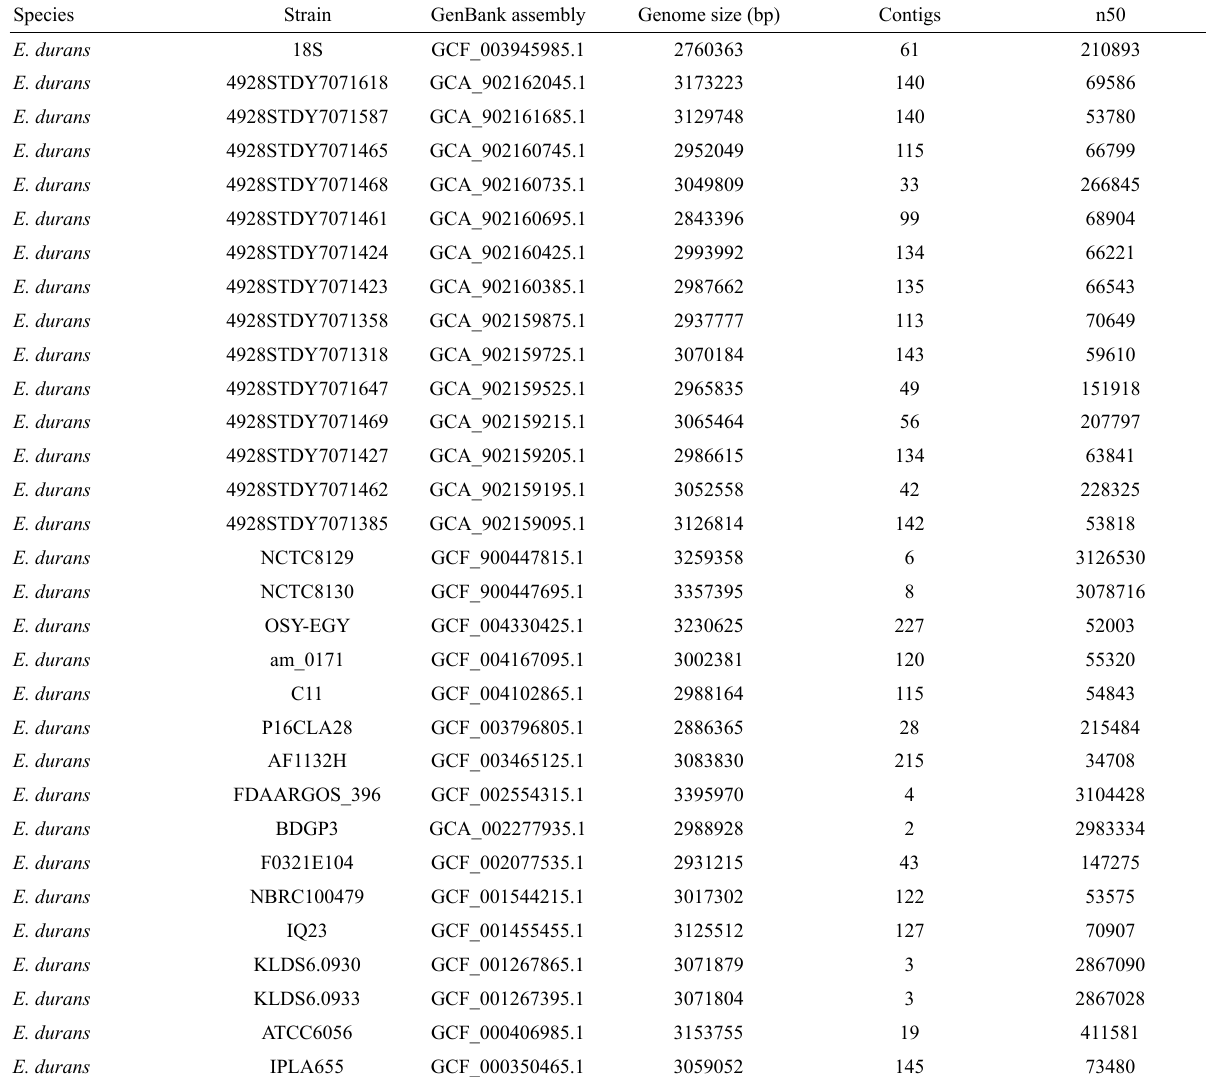
Table 1 – Complementary information of Enterococcus durans genomes from NCBI. Species